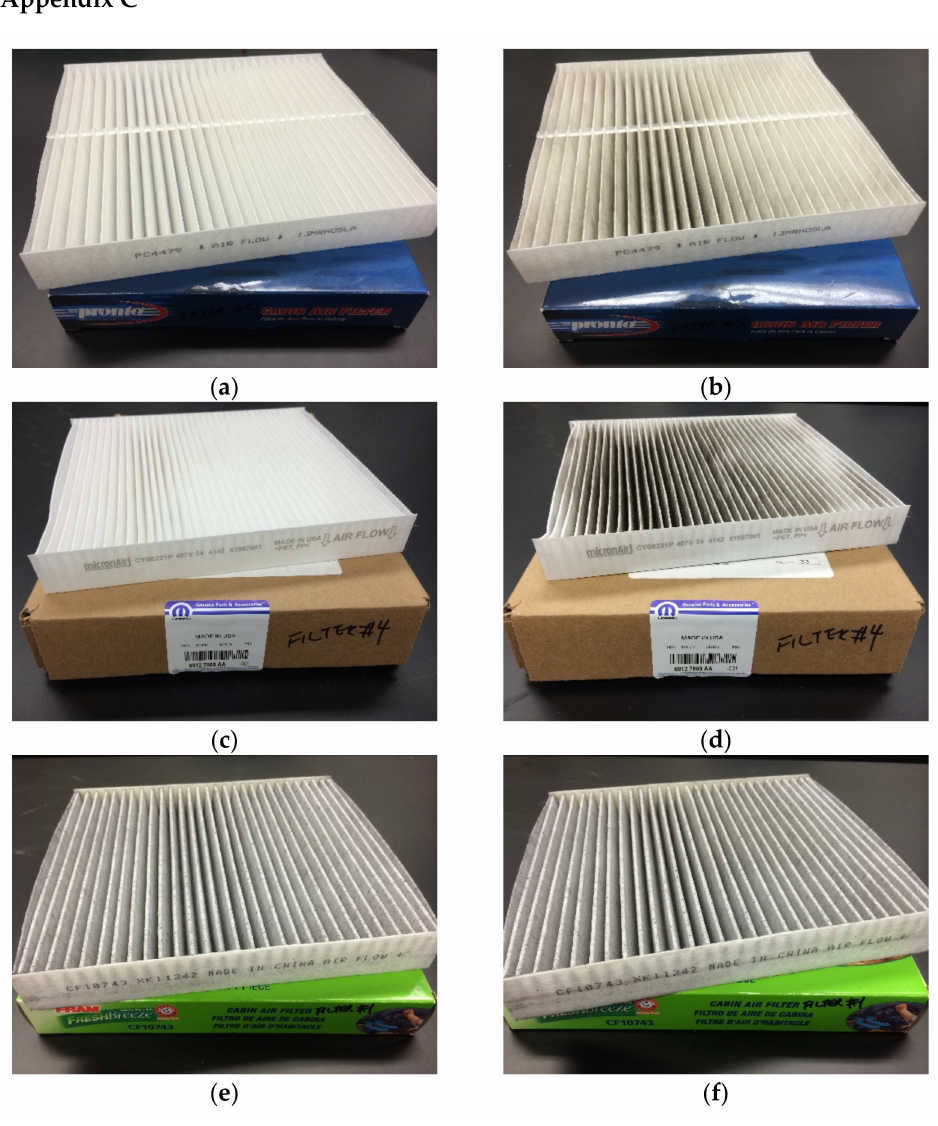
Figure A2. Photos showing a comparison of the appearance of ( a , b ) a standard filter, ( c , d ) an electrostatic fiber filter, and ( e , f ) a charcoal filter before and after the particle filtration efficiency experiment.